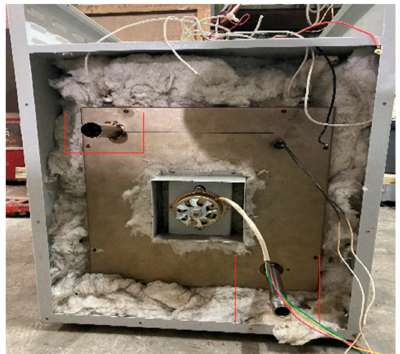
Figure 6. Schematic diagram of adding vent to the thermostat.